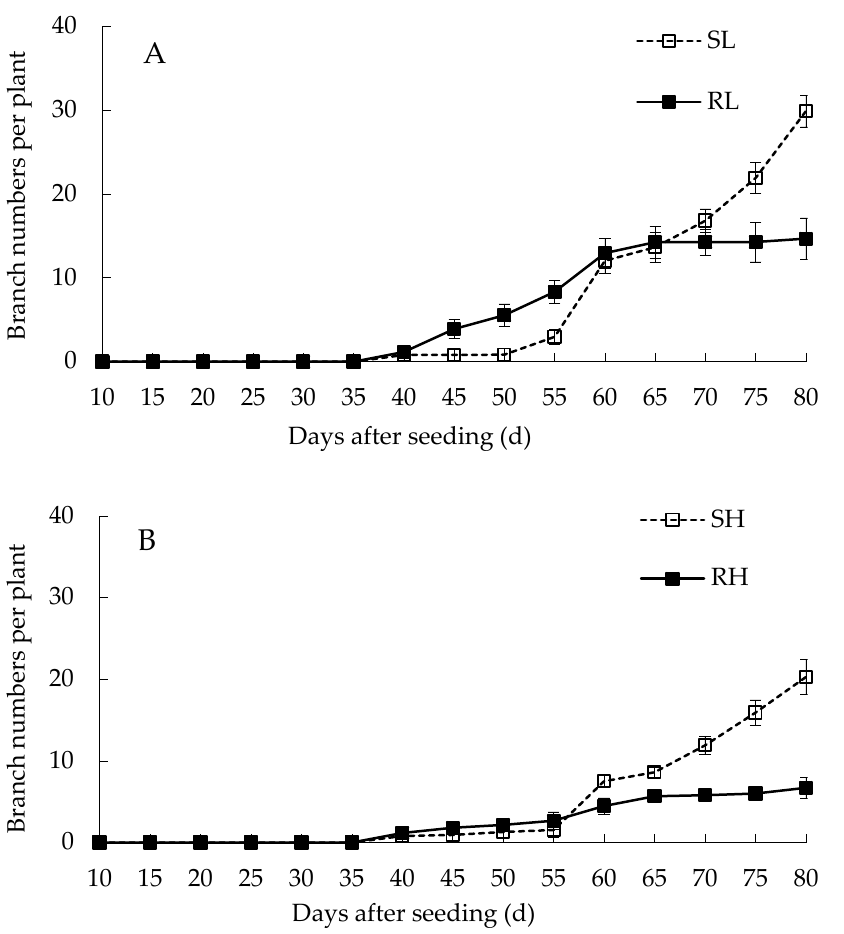
Figure 2. Number of branches (mean ± standard error) of two eared redstem biotypes over time at ( A ) a low eared redstem density of 58 plants m − 2 or ( B ) a high eared redstem density of 288 plants m − 2 . The letters L and H refer to low and high densities, respectively. The letters S and R refer to BSM-susceptible and BSM-resistant biotypes, respectively. The rice seeding rate was 60 kg ha − 1 in all treatments.